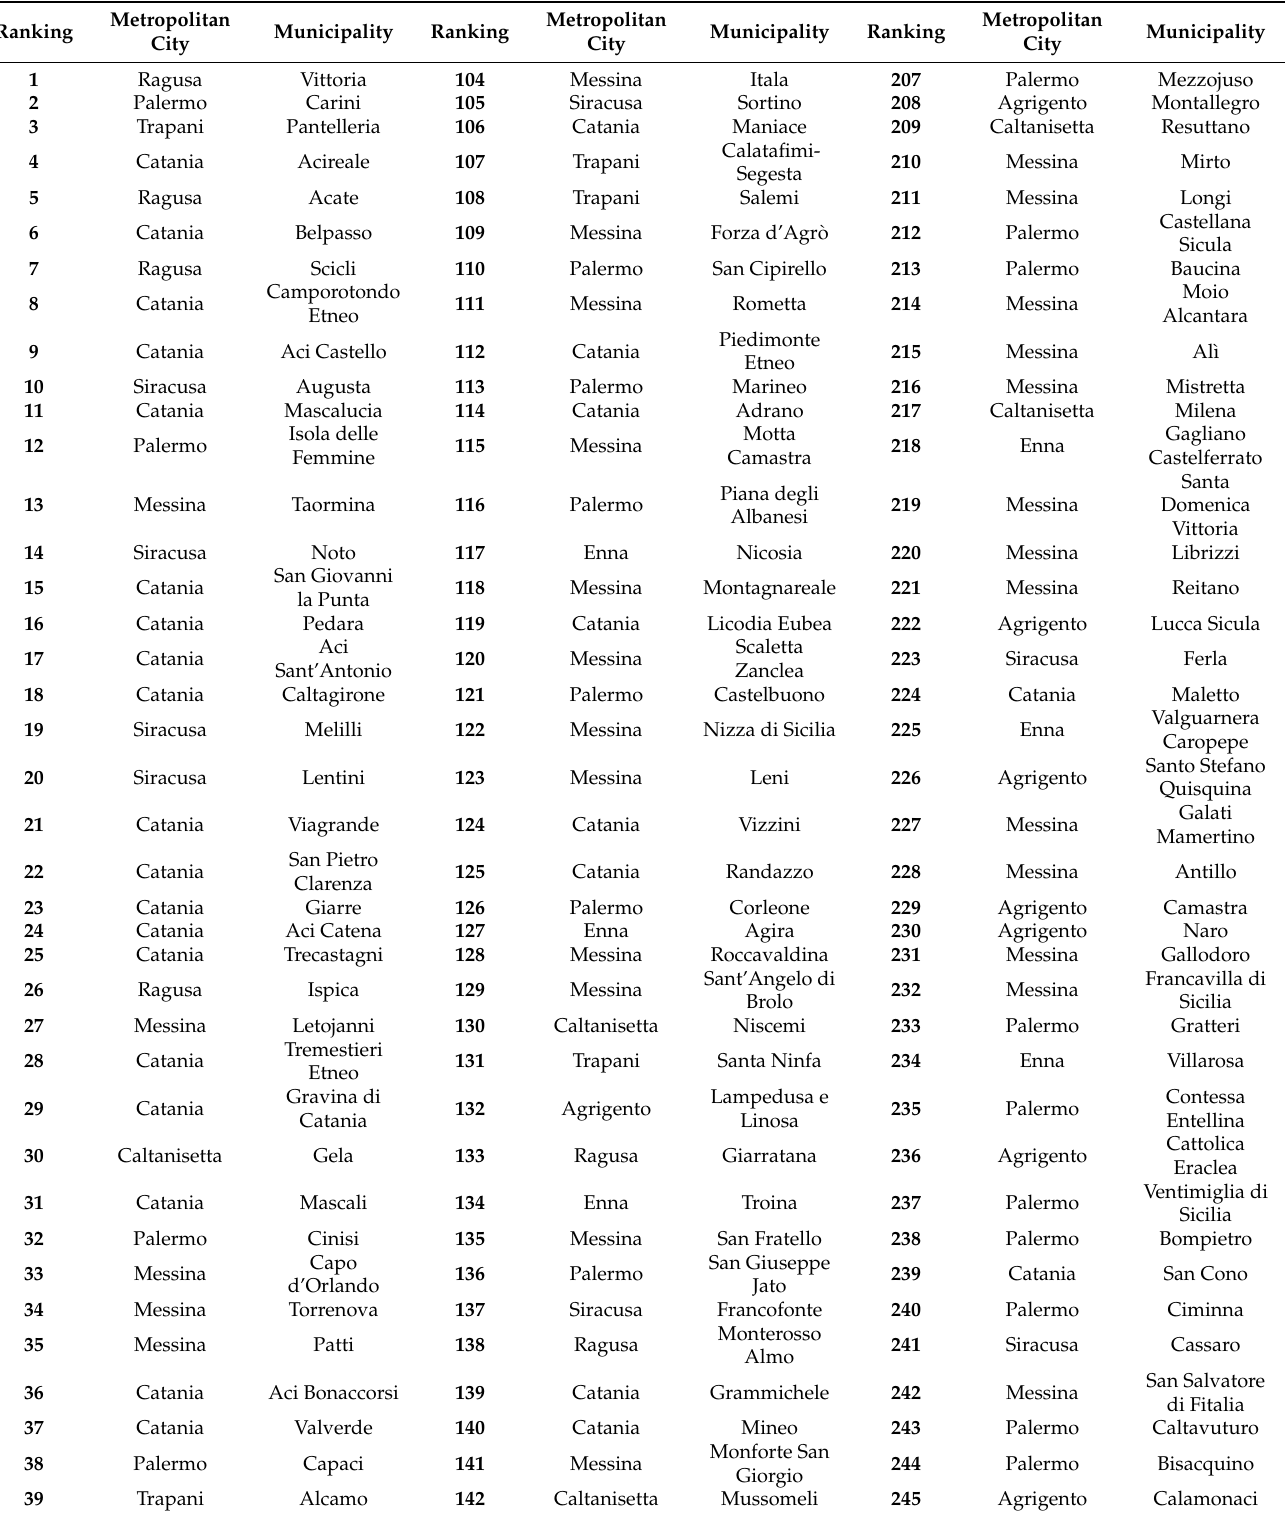
Table A2. Ranking of municipalities based on abandonment index for nine metropolitan cities in